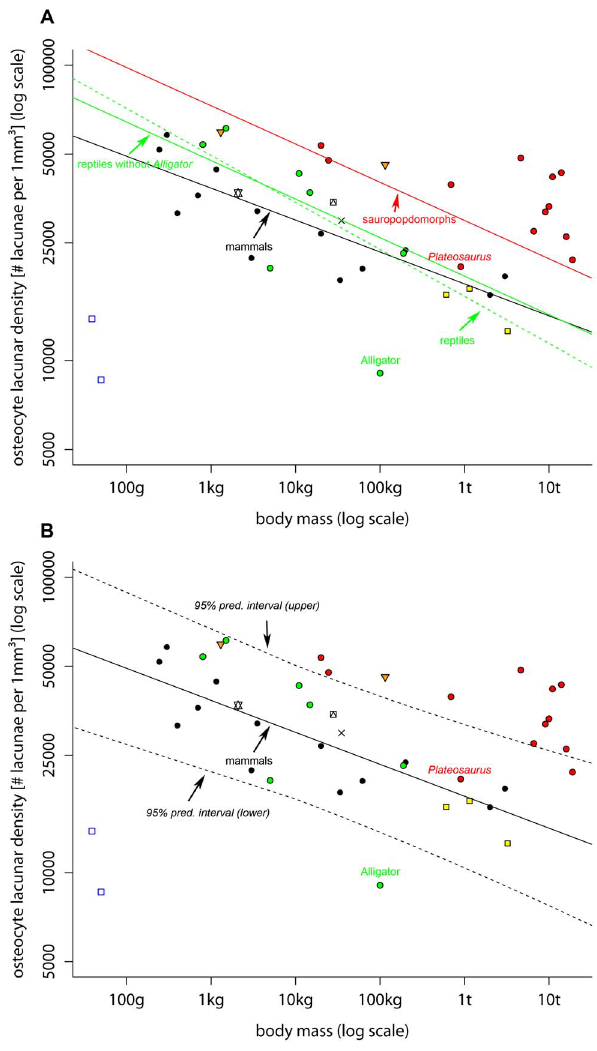
Figure 2. Visualisation of osteocyte lacuna densities in different tetrapods. A. Plot of osteocyte lacunar density on body mass of different taxa on a double logarithmic scale. Lines are the phylogenetic controlled regression lines of the respective taxonomic group. Solid lines represent significant regression models. The scattered line represents a regression model where the slope is not significant different from zero using a significant level of 0.05. For details of the regression models see Table 3. black circles = mammals, red circles = sauropodomorphs, blue open squares = amphibians, yellow squares = theropods, orange triangles = birds, green circles = reptiles, cross = diadectomorphs, star/pentagram = pterosaurs, square with triangle = ‘‘pelycosaurs’’. B . Studied species in comparison to the mammal regression model (solid line). Scattered lines are 95% prediction intervals of the mammal regression model. Symbols as in A